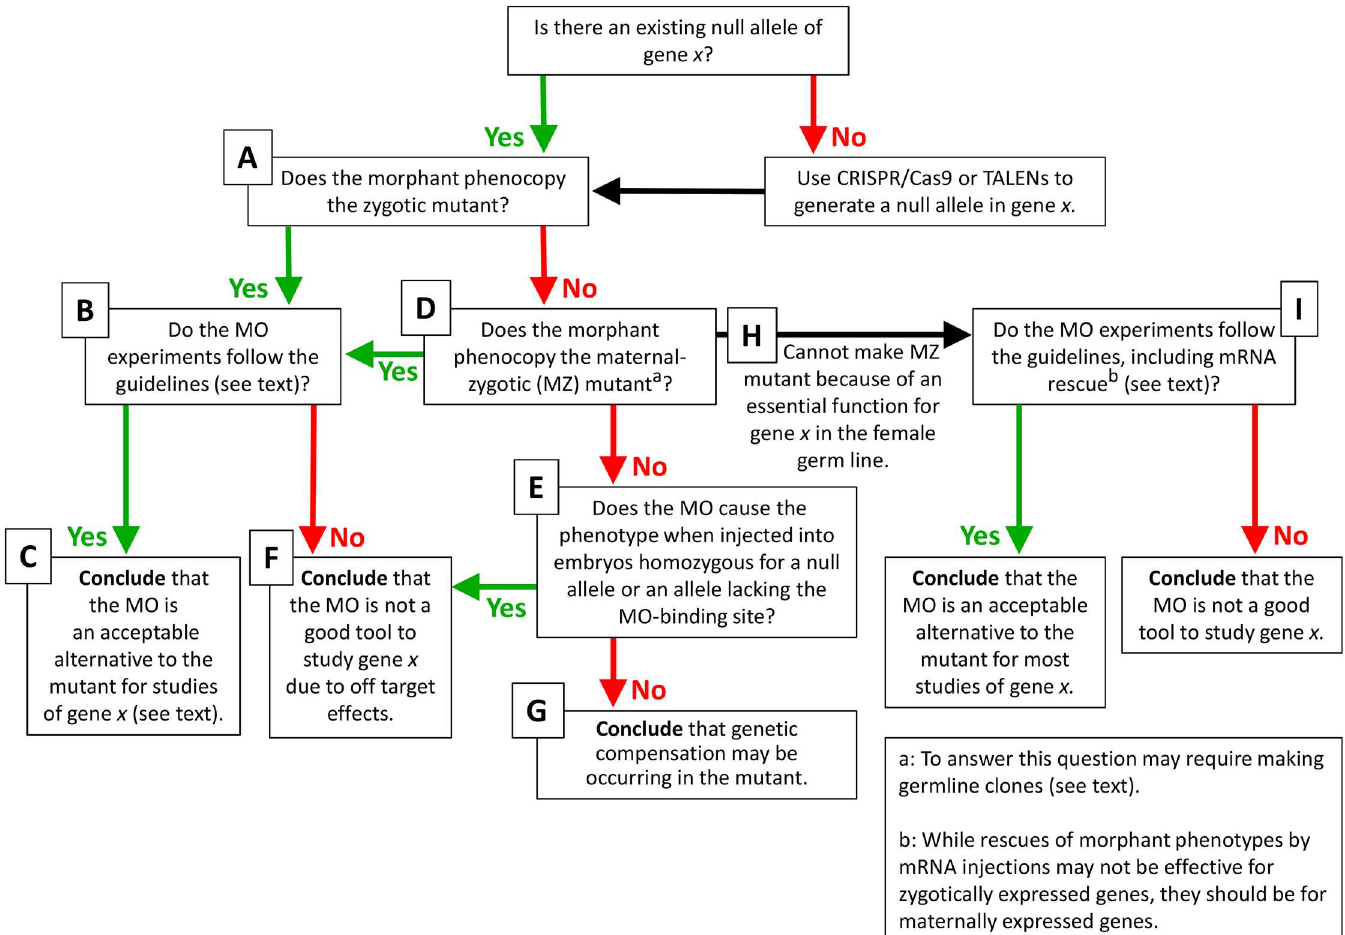
Fig 1. Flowchart for zebrafish researchersinterested in using morpholinos (MOs) to study the function of gene x .